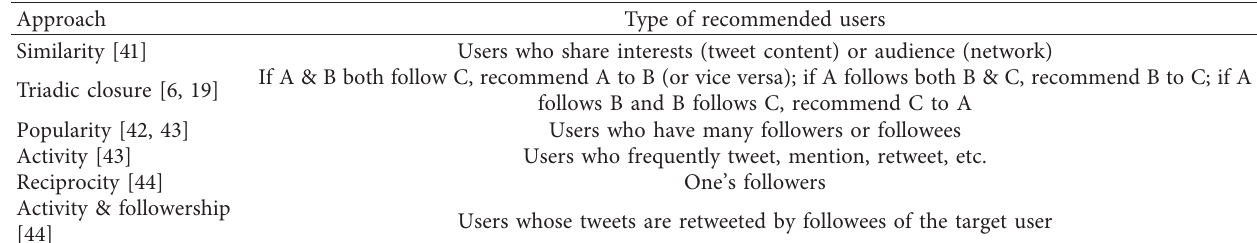
Table 1: Overview of typical recommendation